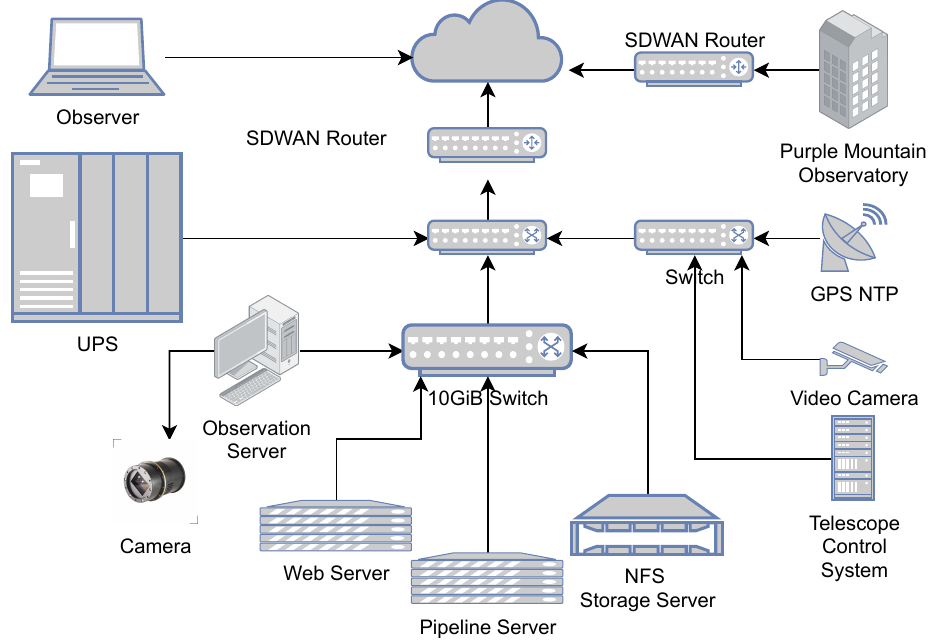
Figure 2. AST3-3 private and local area Internet